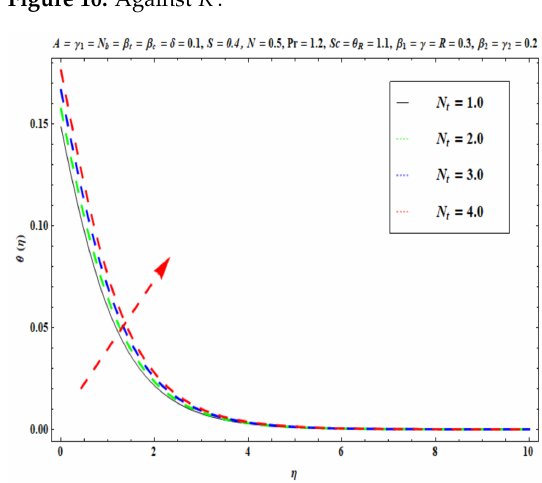
Figure 11. Against N t .